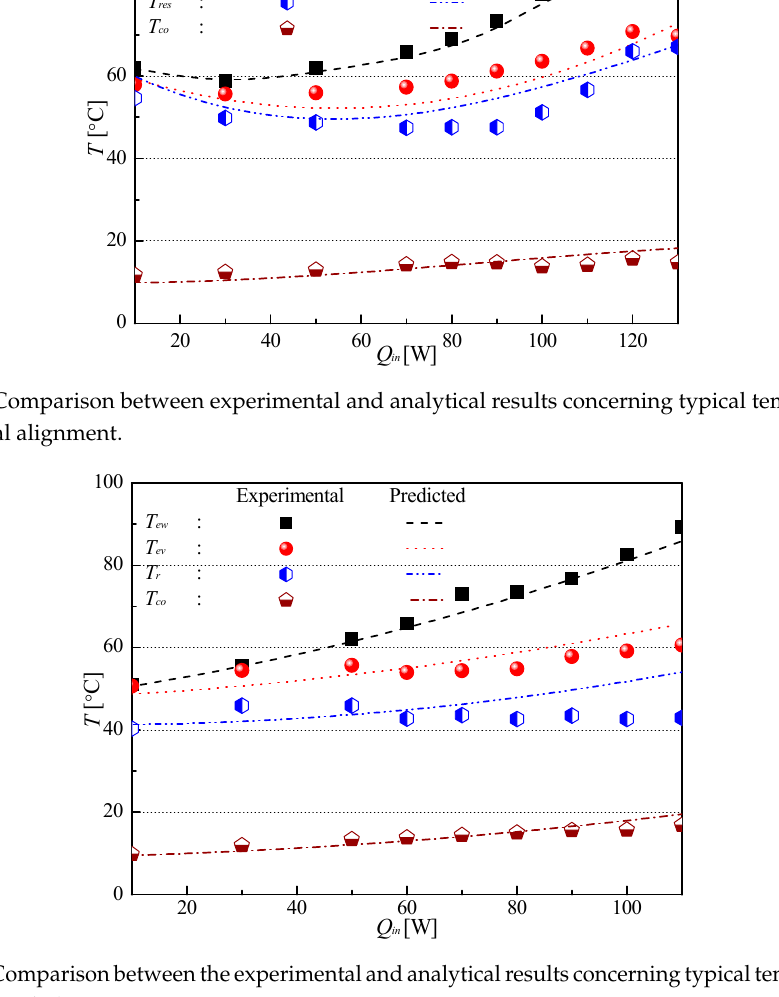
Figure 10. Comparison between experimental and analytical results concerning typical temperatures at horizontal alignment.